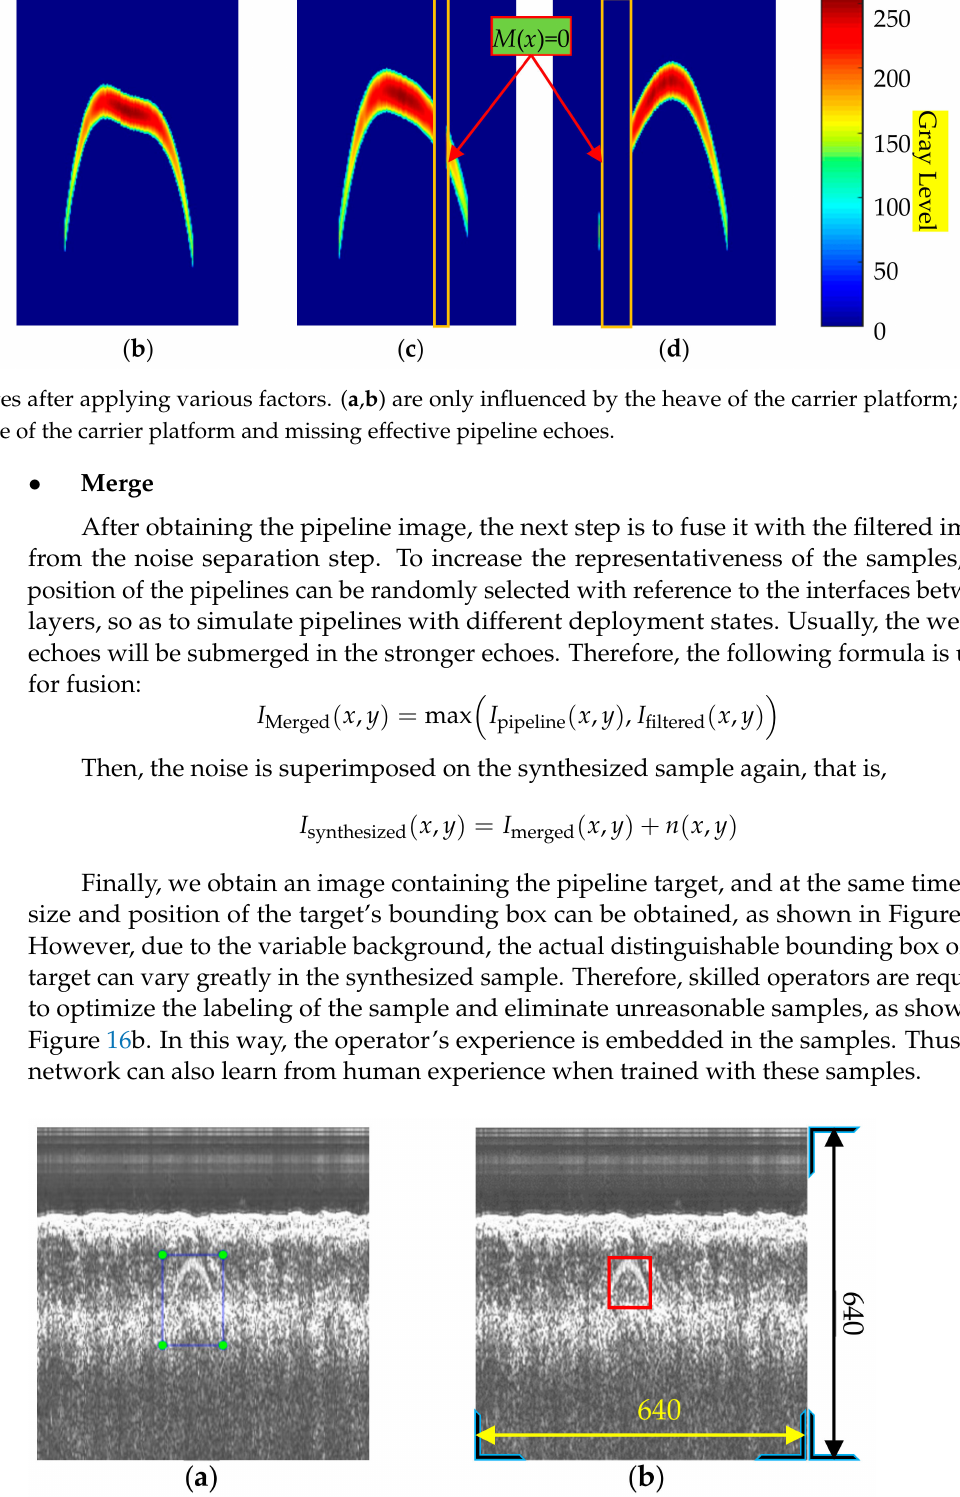
Figure 16. A generated pipeline sample. ( a ) Bounding box obtained during the sample synthesis process; ( b ) bounding box with manual